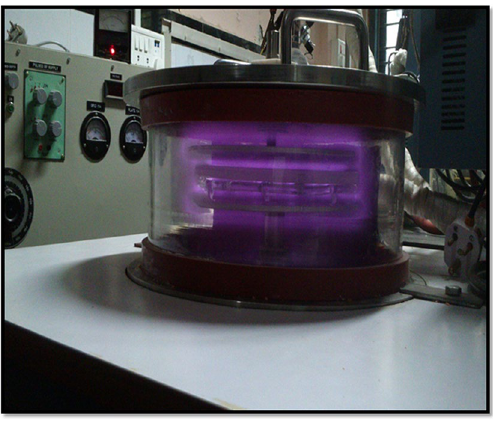
Figure 2. Photograph of the low-temperature plasma